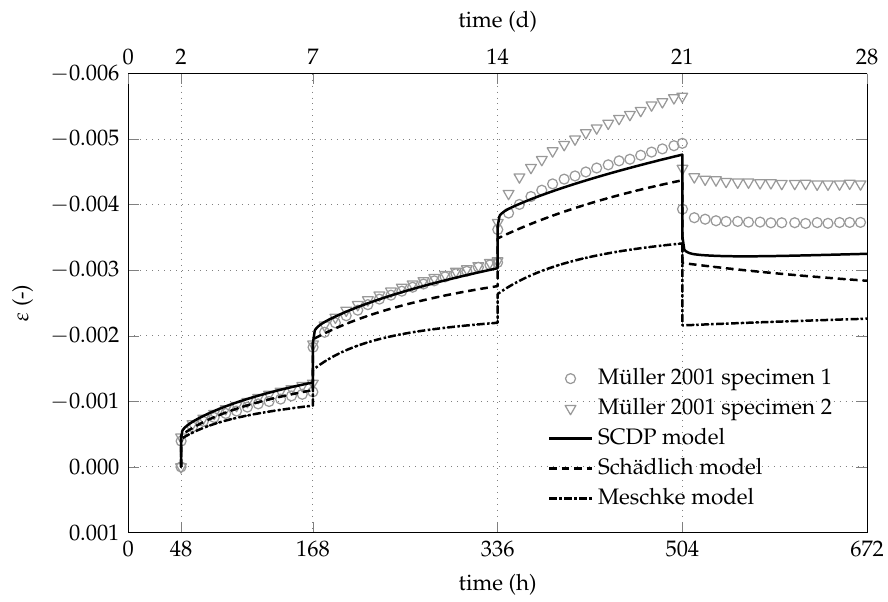
Figure 3. Measured and predicted evolution of the total strain of the two specimens of creep test series No. 4/2 in creep tests on unsealed specimens by Müller [21].